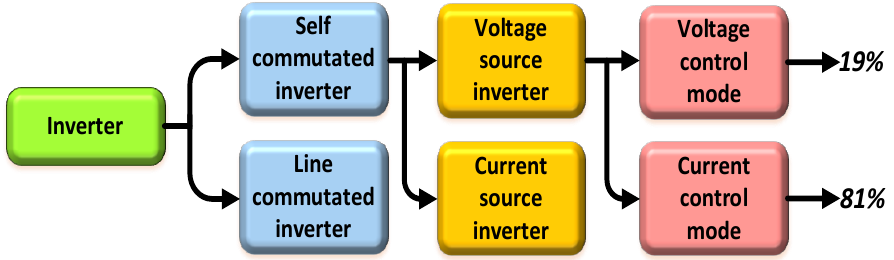
Figure 9. Classification of inverters based on commutation [53].